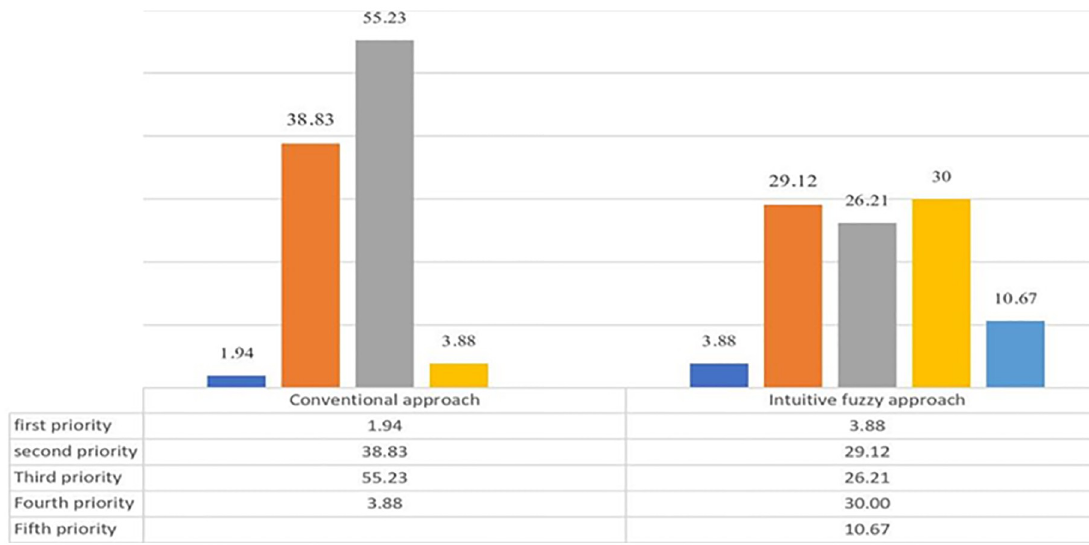
Fig 9. Relative frequency of risk level of deviations detected in convectional and fuzzy